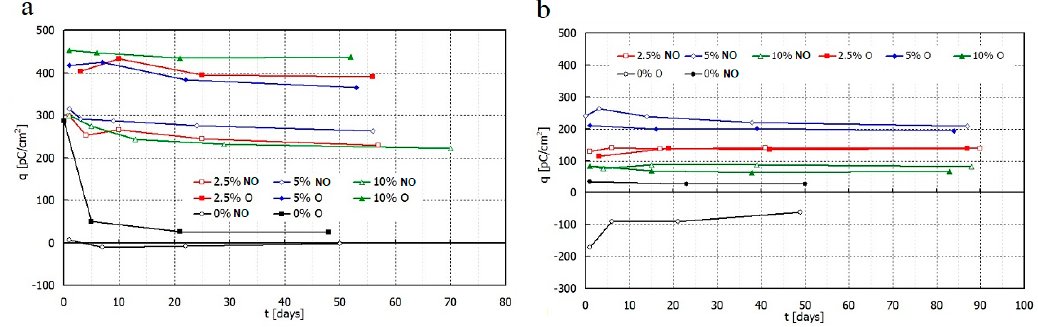
Figure 7. Dependence of piezoelectric charge vs storing time for non-oriented (NO) and oriented (O) films HDPE+Sillikolloid P87 ( a ) and MDPE+Sillikolloid P87 ( b ) at room temperature.